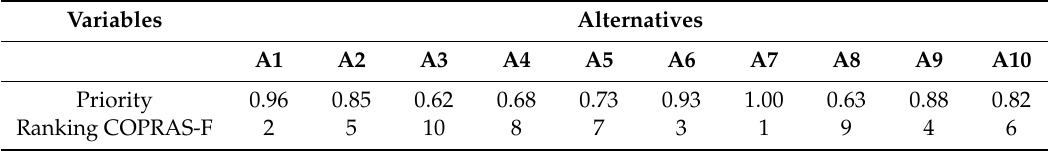
Table 10. MCDM COPRAS-F ranking.